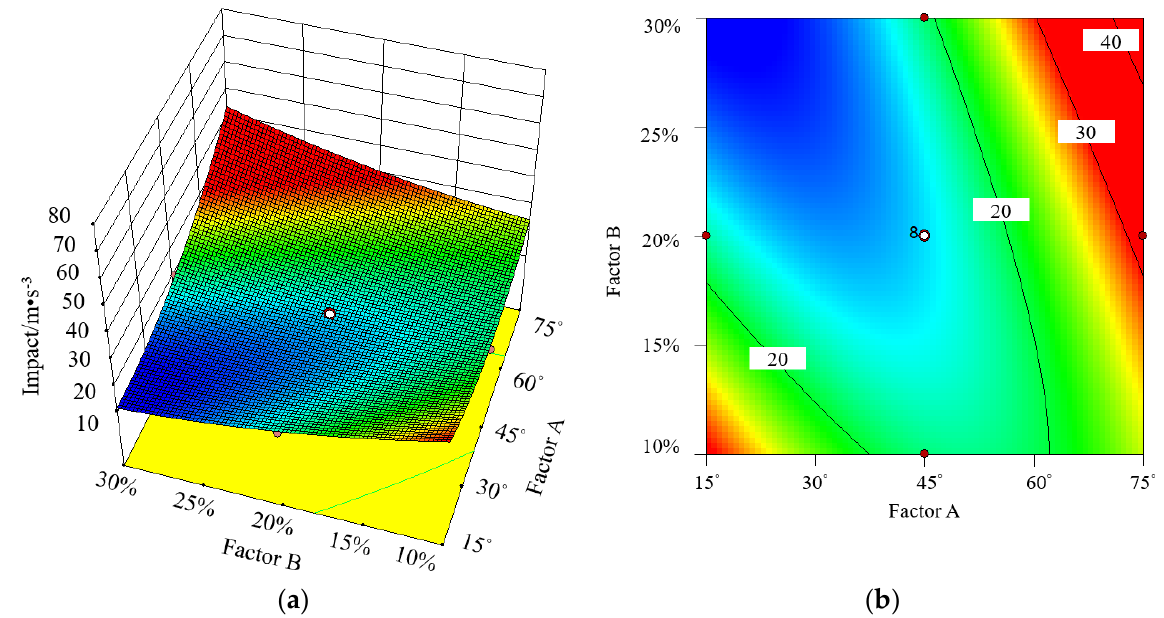
Figure 11. Response surface diagram and contour map of factor A and B on interaction of impact degree. ( a ) Response surface diagram; ( b ) contour map. The three contour lines mapped on the bottom of Figure 11a correspond to the three types of impact degree in Figure 11b. Table 8. Significance test of the full engagement time regression